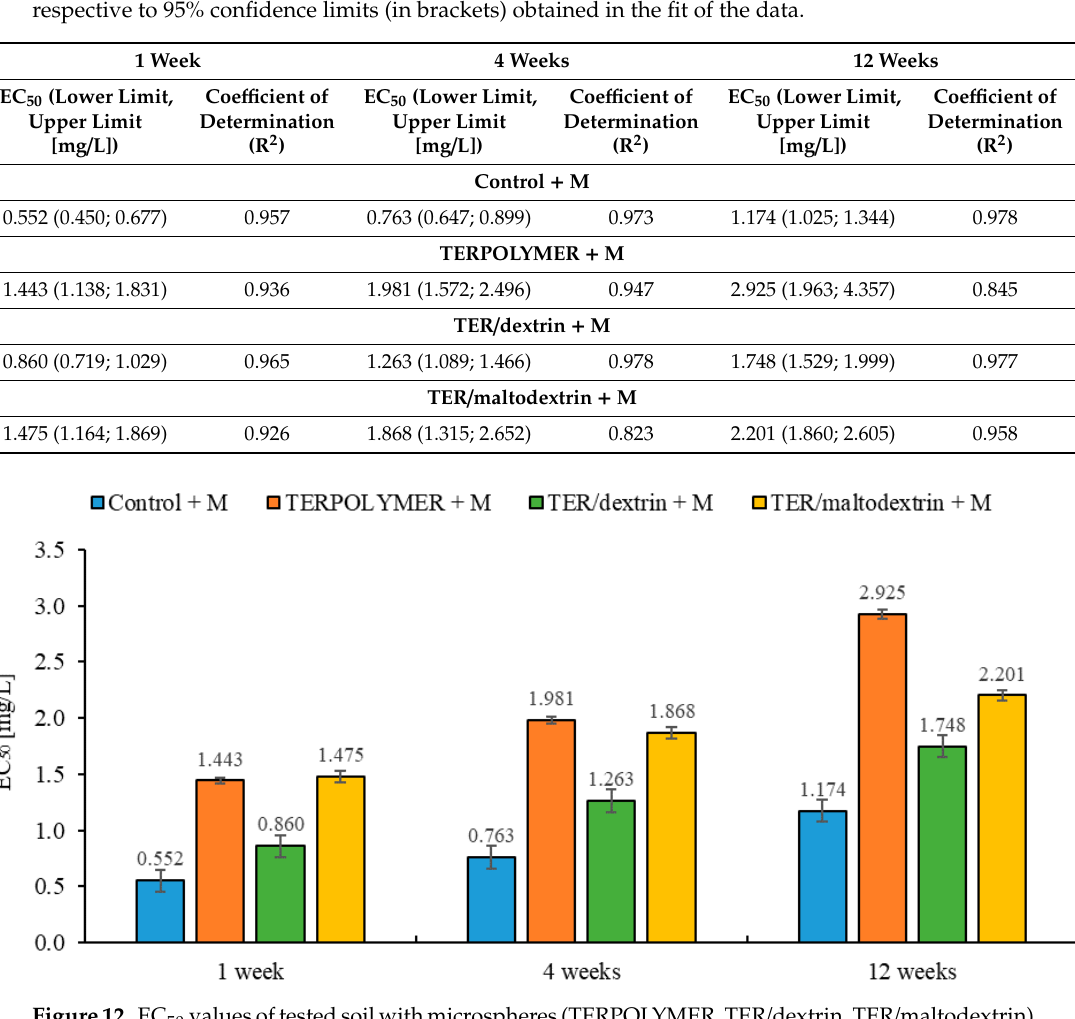
Table 6. Microtox ® EC 50 values (mg/L) of exposure of the luminescent marine bacteria A. fischeri to tested soil with microspheres (TERPOLYMER, TER/dextrin, TER/maltodextrin) with metazachlor respective to 95% confidence limits (in brackets) obtained in the fit of the data.